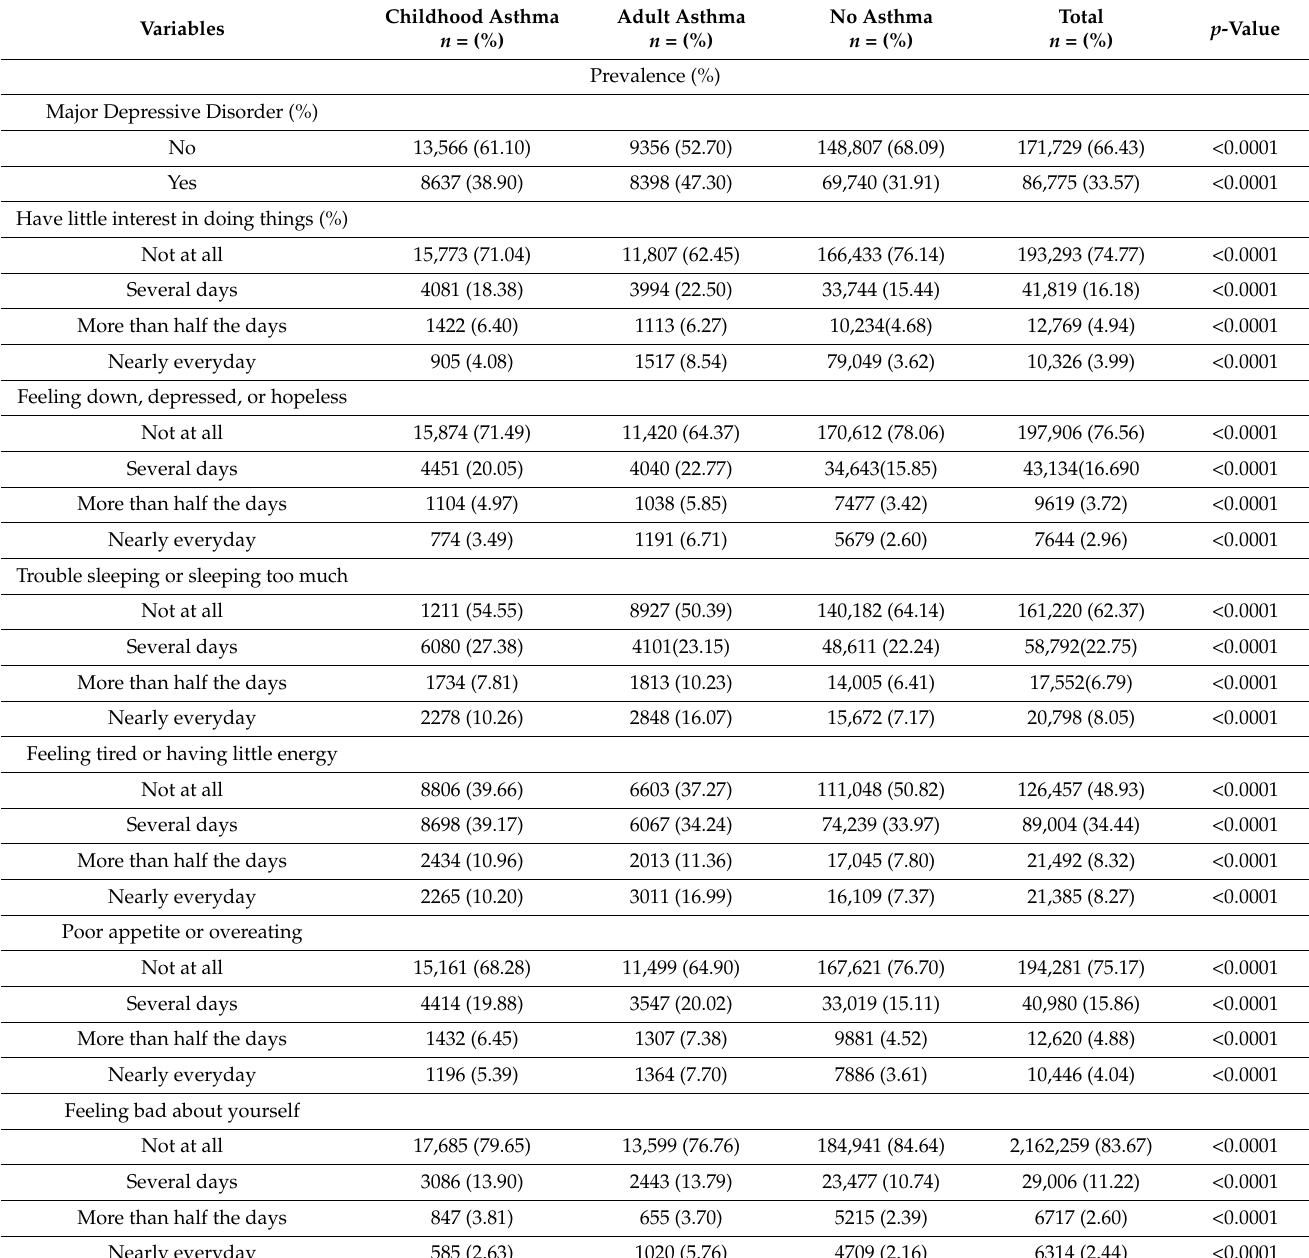
Table 2. Univariate analysis of childhood and adult responses to major depressive disorder and low-mood-related